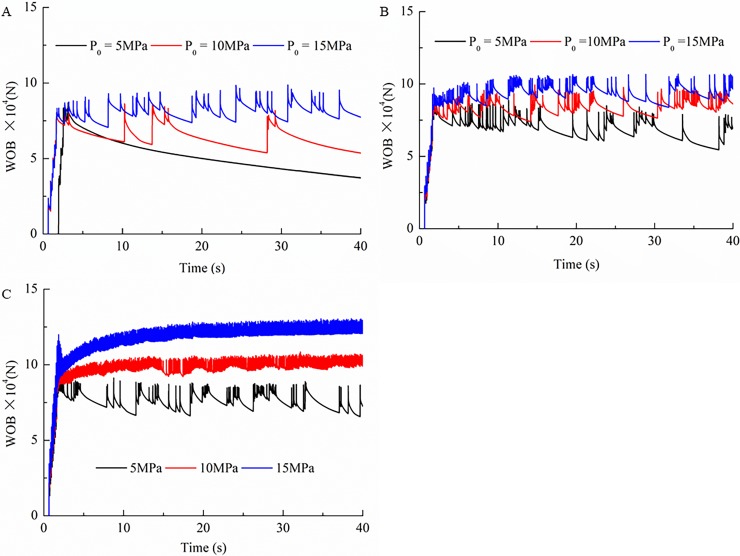
Effect of pressure pulse amplitude on WOB at different frequencies.(A) f = 2 Hz. (B) f = 6 Hz. (C) f = 10 Hz. https://dx.doi.org/10.17504/protocols.io.ke9cth6.